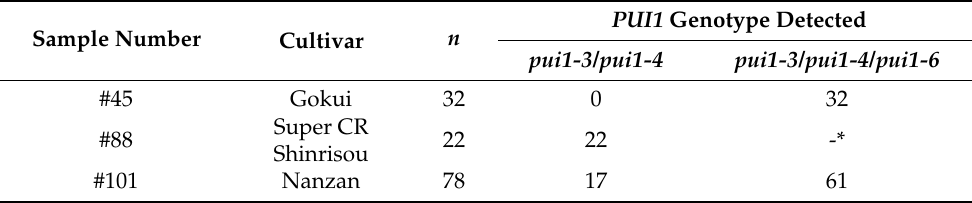
Table 2. Segregation analysis of PUI1 allele in the selfed progeny of #45, #88, and #101.